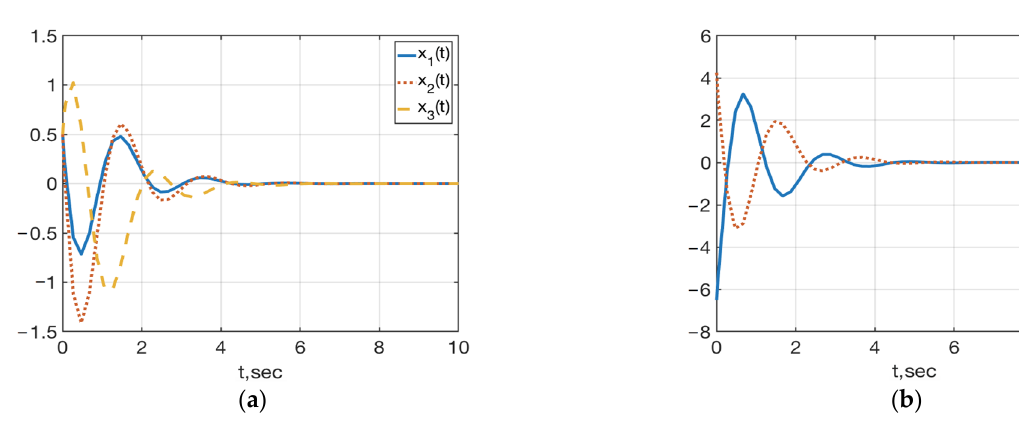
Figure 1. ( a ) Plots of x 1 ( t ) , x 2 ( t ) , x 3 ( t ) ; ( b ) Plots of u 1 ( t ) , u 2 ( t ) in the closed-loop system (59), (62) with x ( 0 ) = ( 0.5, 0.5, 0.5 ) T